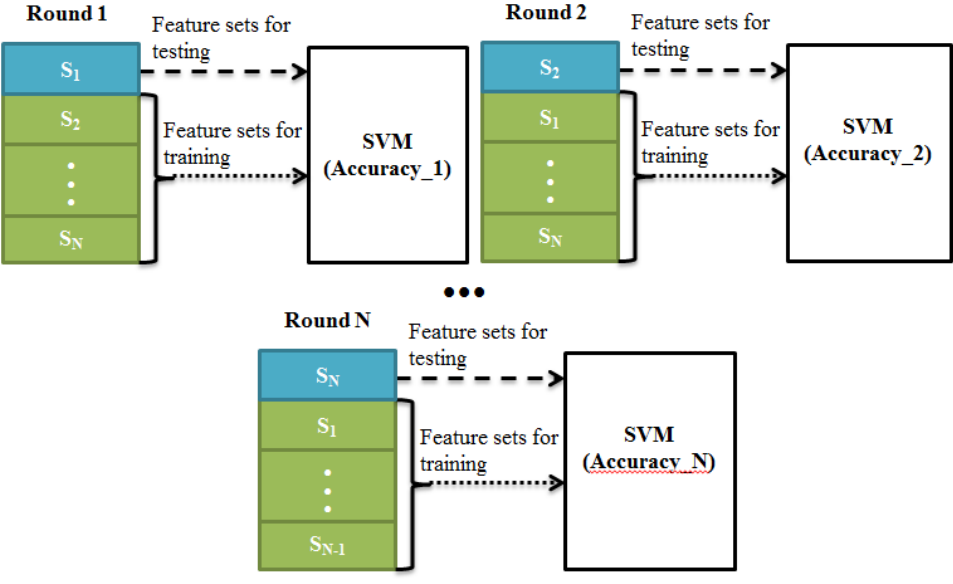
Figure 4. The procedure of LOO cross-validation and optimization, where S i means the i -th subject and Accuracy_i means the classification accuracy for i -th